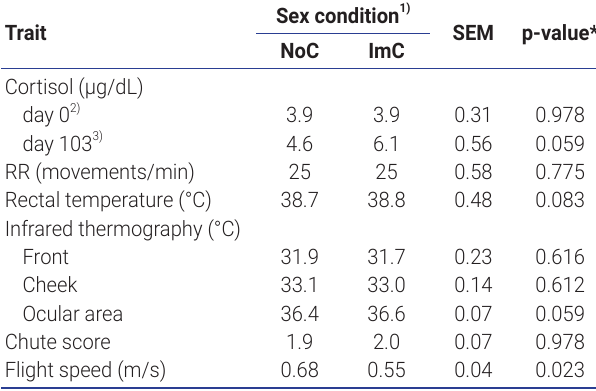
Table 3. Effects of immunocastration on cortisol, respiration rate, body temperature, and temperament scores